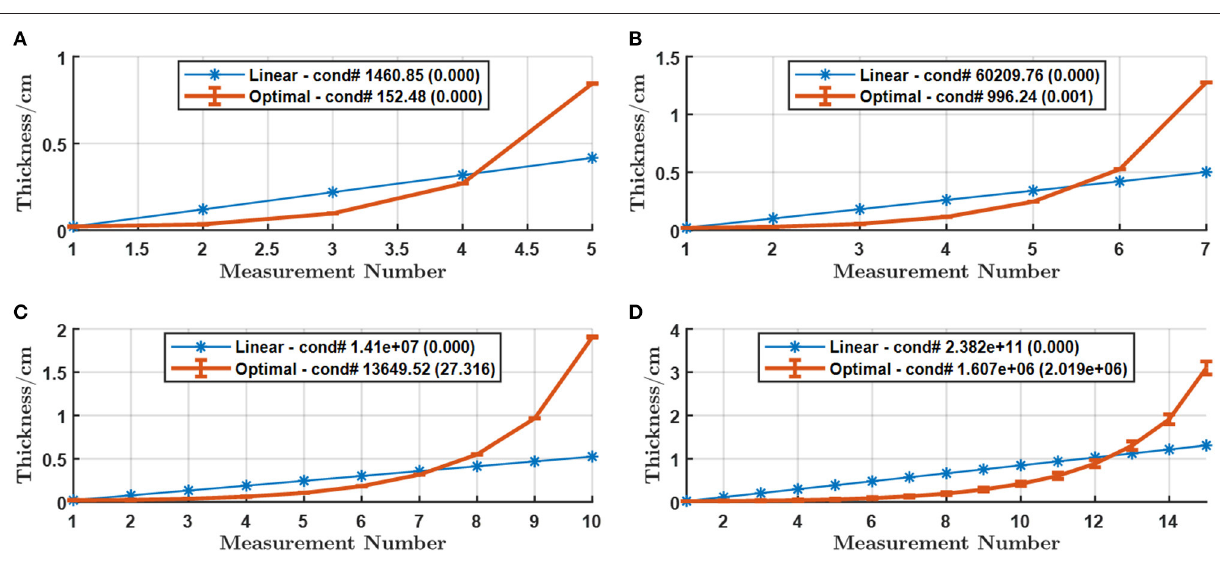
FIGURE 6 | Optimal thickness arrangement against the best linear arrangement for (A) M [0.02, 10] cm. The error-bars in the curve stand for the standard deviation of the thickness while the number in parentheses in the legend is the standard deviation of the condition number for 30